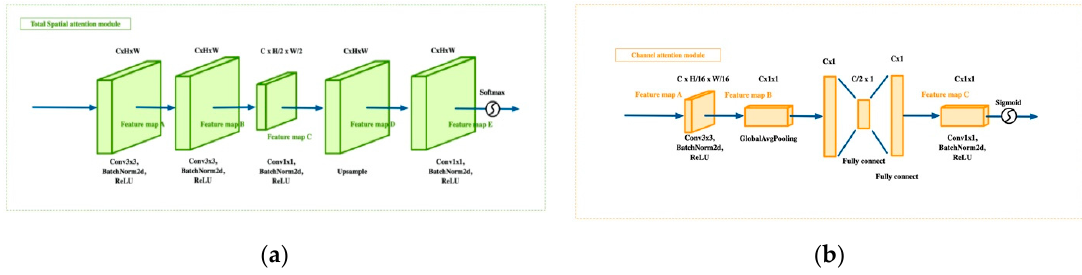
Figure 8. Squeeze-and-Excitation operations added to ( a ) the total spatial attention module and ( b ) the channel attention module.